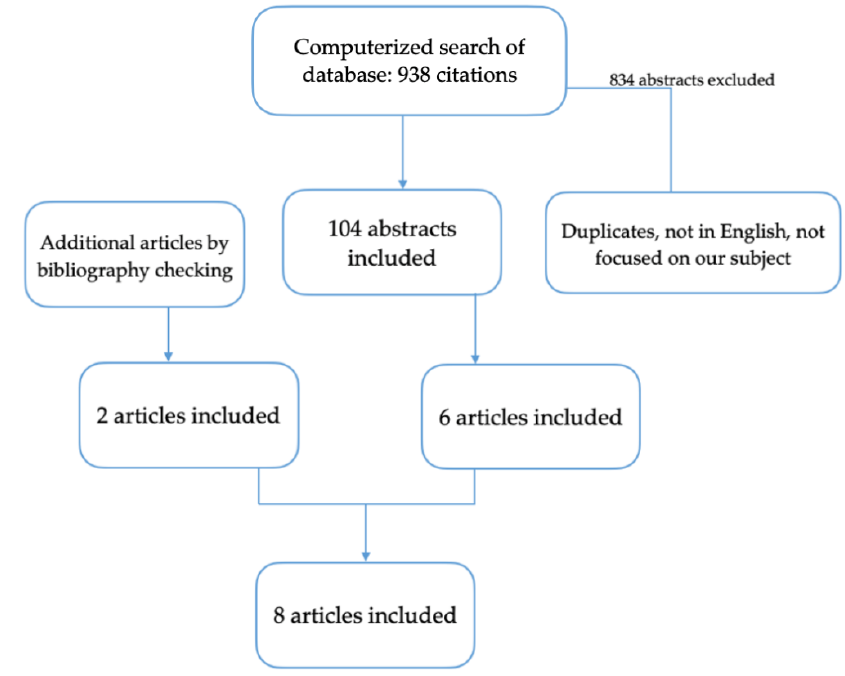
Figure 1. Flow diagram of the search process.